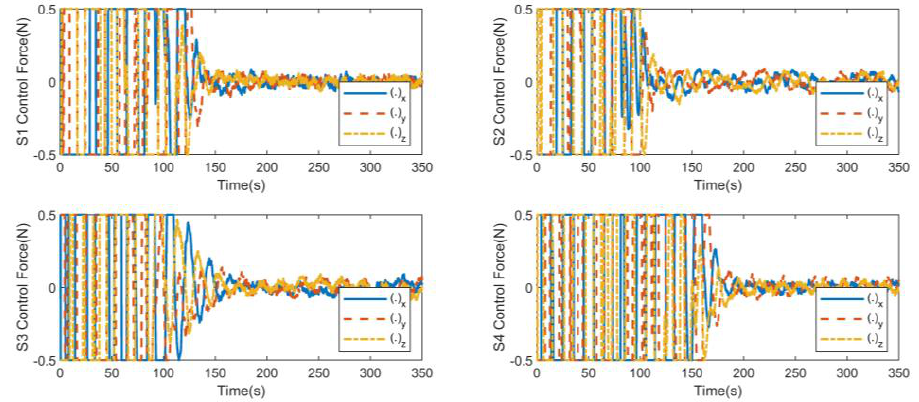
Figure 13. S1, S2, S3, S4 control force for consistent collaborative control.